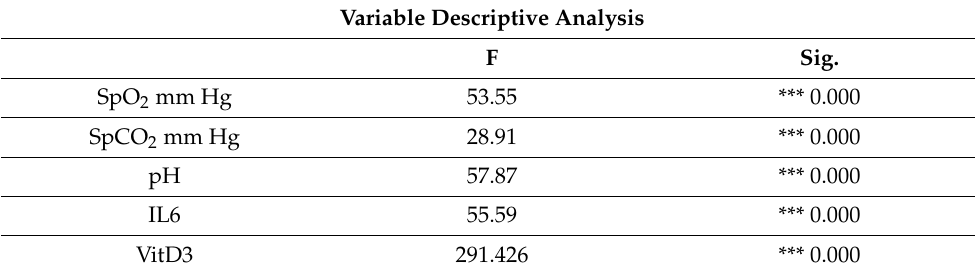
Table 4. ANOVA. Descriptive analysis related to ABG, IL6, and Vit-D3.